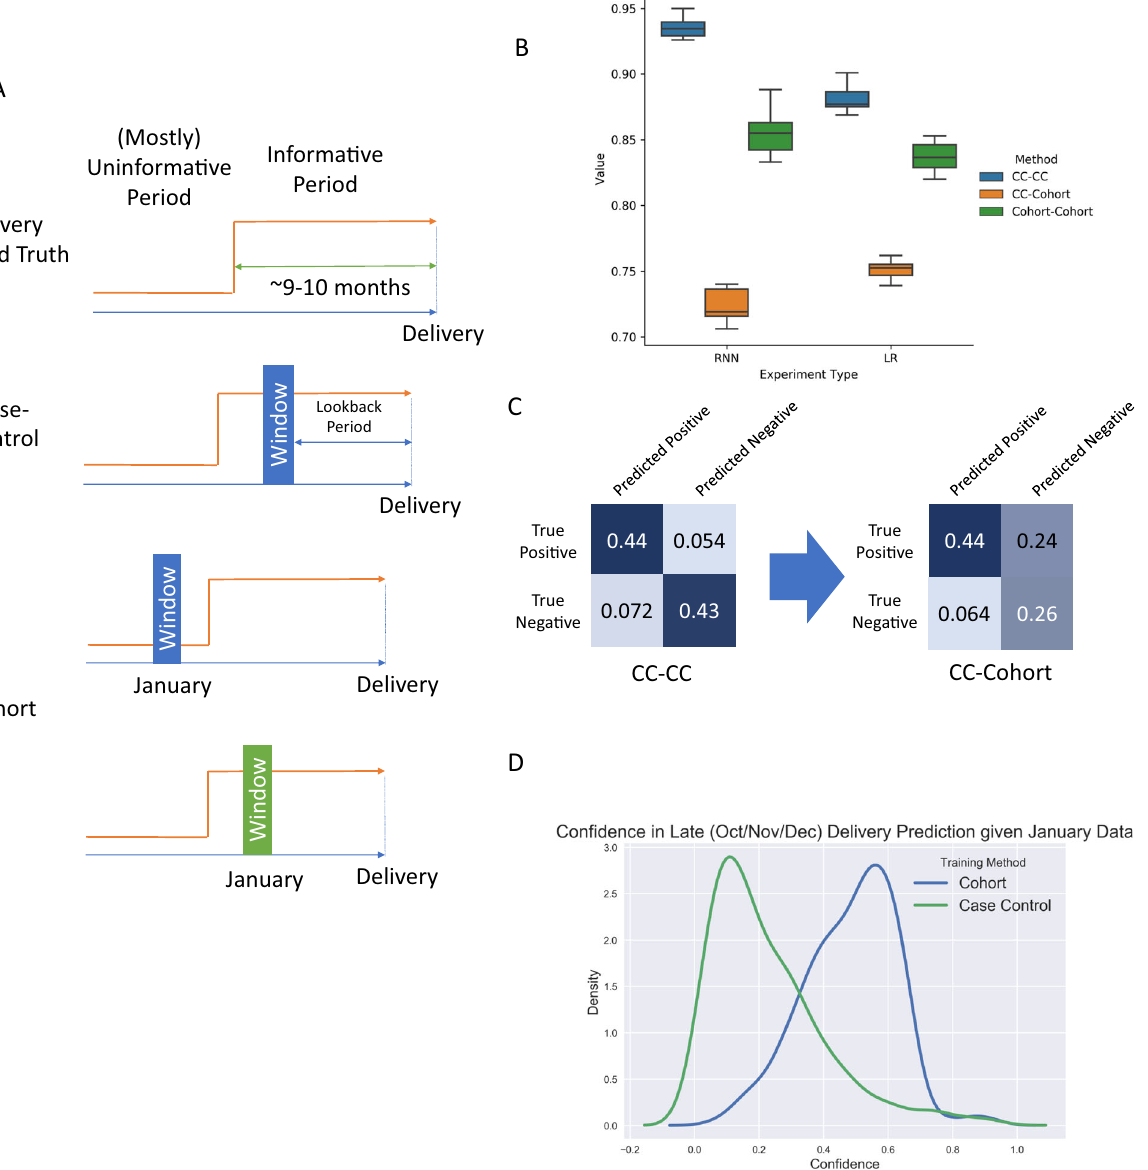
Fig. 2 Case-control predictors for delivery report false negatives when applied prospectively due to temporal bias. A The ground truth trajectory for delivery (orange) is composed of parts: an informative period, 9 – 10 months prior to the delivery, and a largely uninformative period prior. Case-control windows (blue) are indexed to delivery/baseline date, and so only sample a single (informative) slice of the trajectory. Cohort windows (green) always occur in January, and so uniformly sample the trajectory. B Model performance (Validation AUROC) for deep recurrent neural networks and logistic regression for each study design. Error bars represent the 95% con fi dence intervals. Each box represents the results of 10 independently trained models. Box bounds represent upper quartile, lower quartile, and mean. Whiskers represent maxima and minima. C Comparison of confusion matrices for CC-CC (left) and CC-Cohort (right) models. Color intensity corresponds to matrix value. D CC-Cohort validation model con fi dence distributions for late (Oct/Nov/Dec) deliveries given January